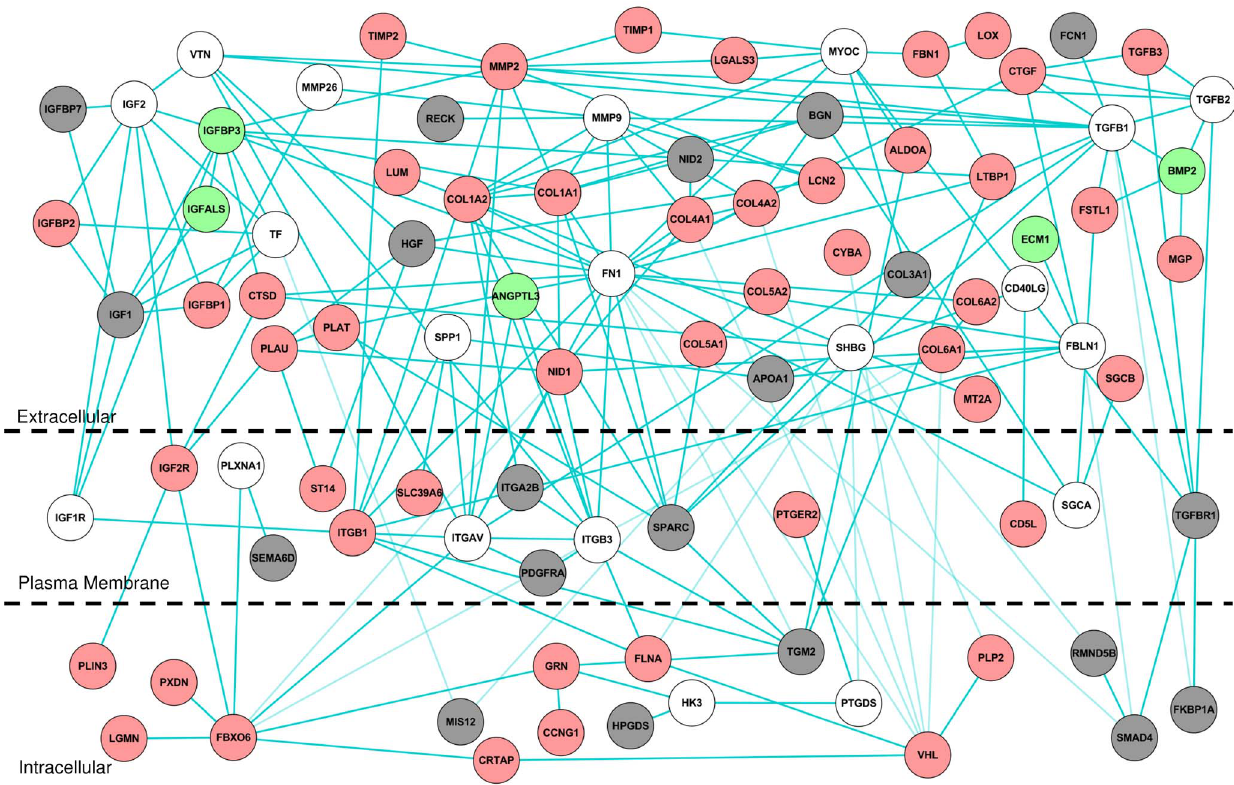
Figure 5. Liver fibrosis-relevant network module M5. Proteins encoded by genes with average log 2 fold-change ratios . 0.6 are colored in red. Proteins encoded by genes with average log 2 fold-change ratios ,2 0.6 are colored in green. Proteins encoded by genes with average log 2 fold- change ratios between 0.6 and 2 0.6 ,2 0.6 are colored in grey. Proteins without corresponding gene expression data are shown as white circles.